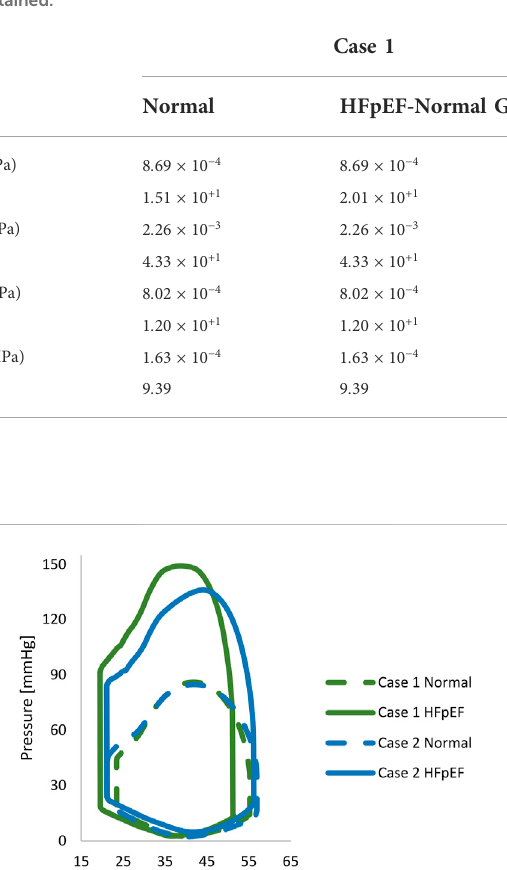
TABLE 5 The passive material properties for each cardiac model, for normal condition and HFpEF condition while the normal geometry was maintained.